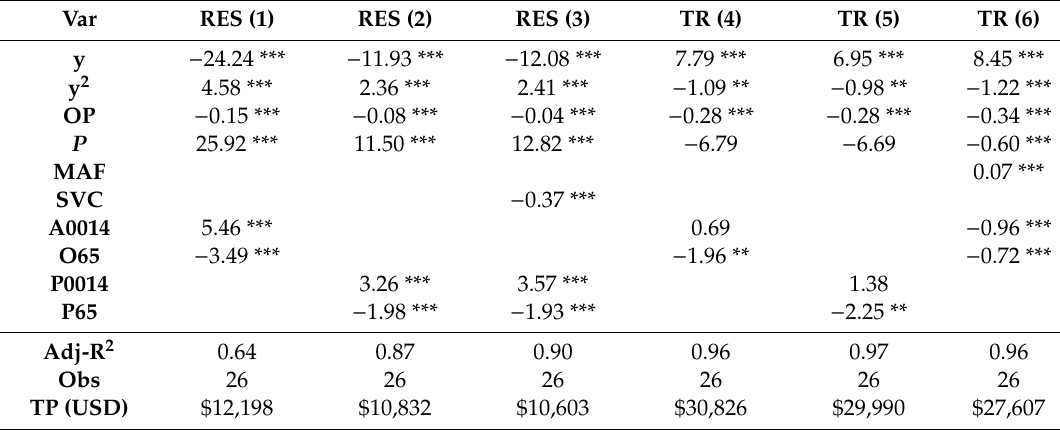
Table 8. Time series FMOLS estimation